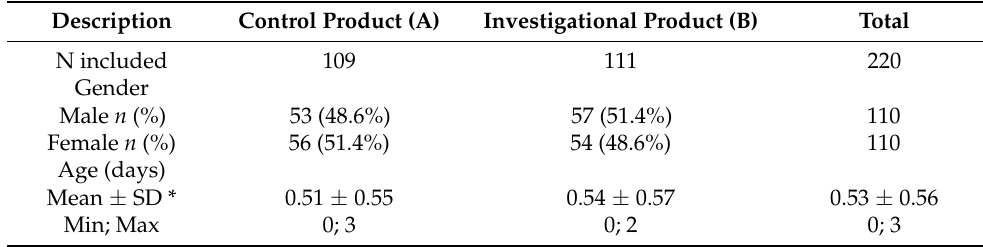
Table 2. Demographic characteristics.